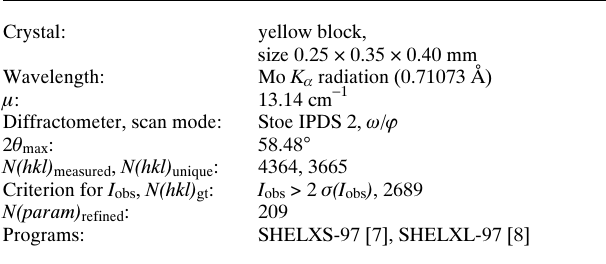
Table 1. Data collection and